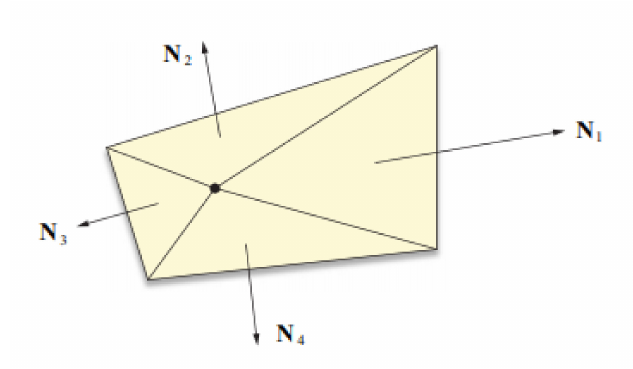
Figure 23. Normals on a 4-sided